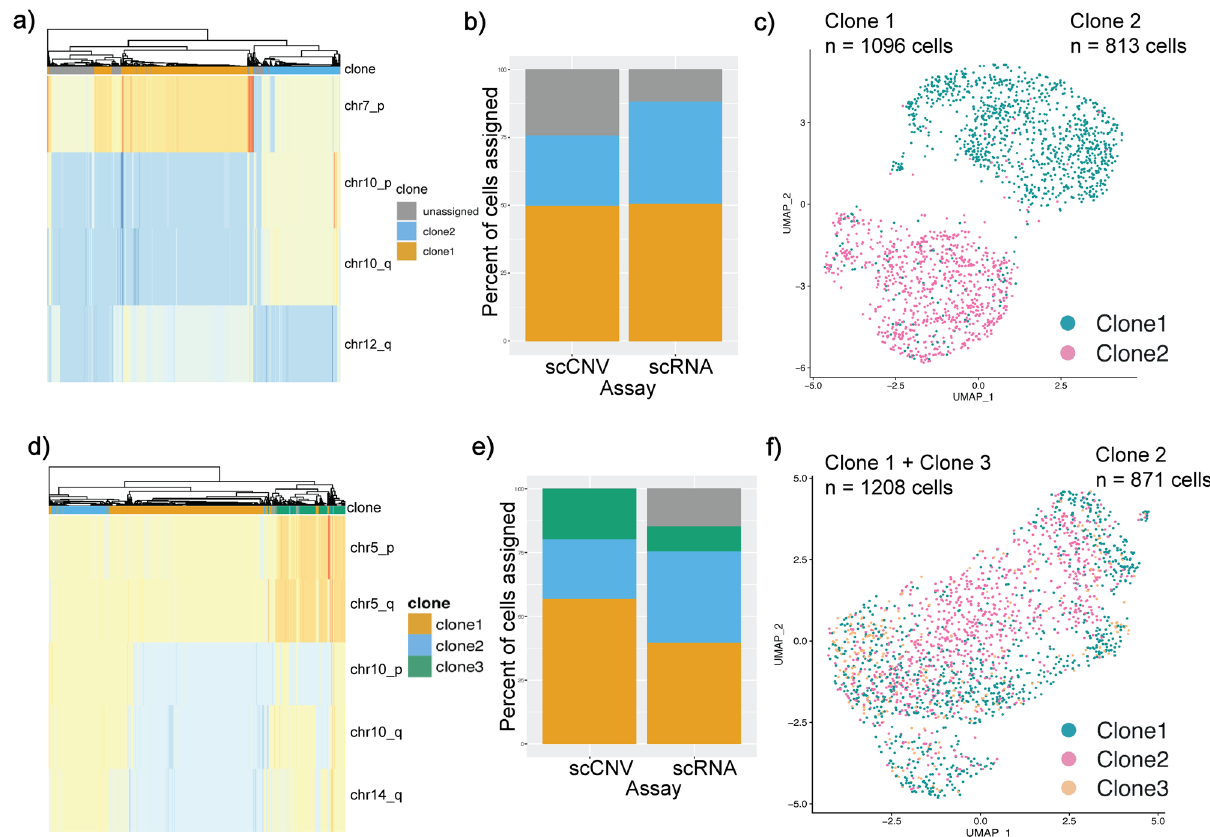
Fig. 4 Evolution of divergent genomic subclones in MiaPaca2 strains has transcriptomic implications. a Genomic clones 1 (orange) and 2 (blue) identi fi ed from scCNV data of MP2-B based on CNV events at chromosomes 7, 10, and 12. b Percentage of cells assigned to clones from scCNV and scRNA datasets. scCNV clones were mapped to corresponding scRNA data using CloneAlign. c UMAP data of MP2-B scRNA expression of single cells overlaid with CNV clones assignment for each cell; Clone 1 in green and Clone 2 in pink. d – f Same as a – c for